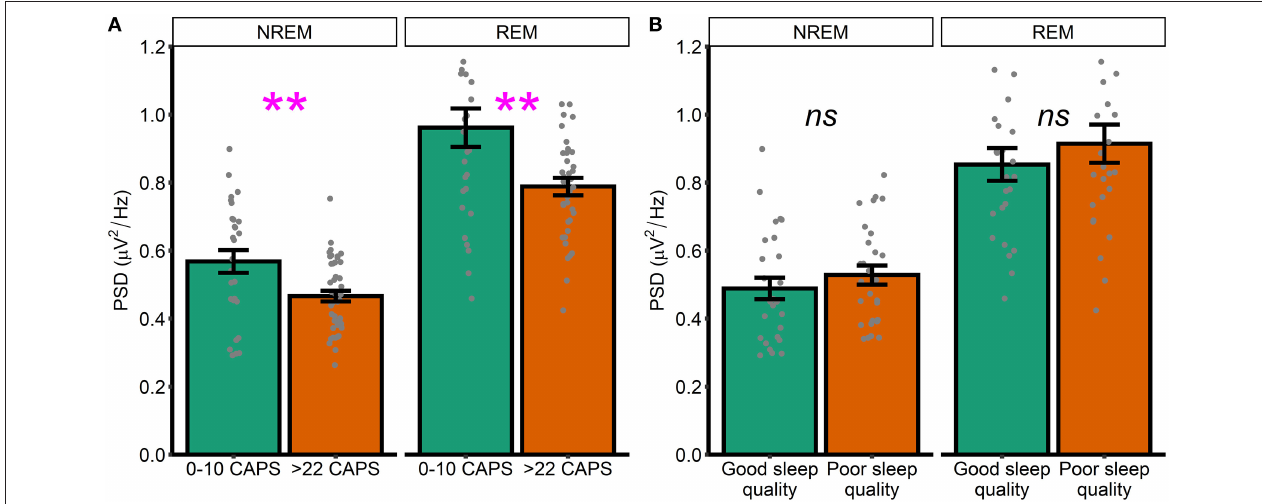
FIGURE 3 | High and low symptomatology participants. (A) High frequency spectral power in low and high PTSD symptomatology participants, as defined by CAPS scores. (B) High frequency spectral power participants with good and poor sleep quality, as defined by global PSQI score. Note that PSD at each frequency is relative to the average PSD in the 0–30Hz range Error bars = standard error. ** p < 0.01, ns , not significant.